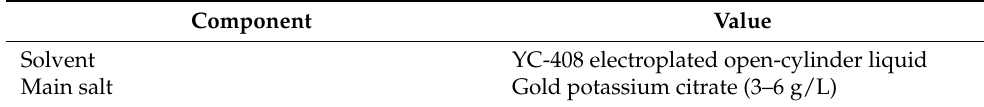
Table 1. Composition of the solution for gold electroplating.